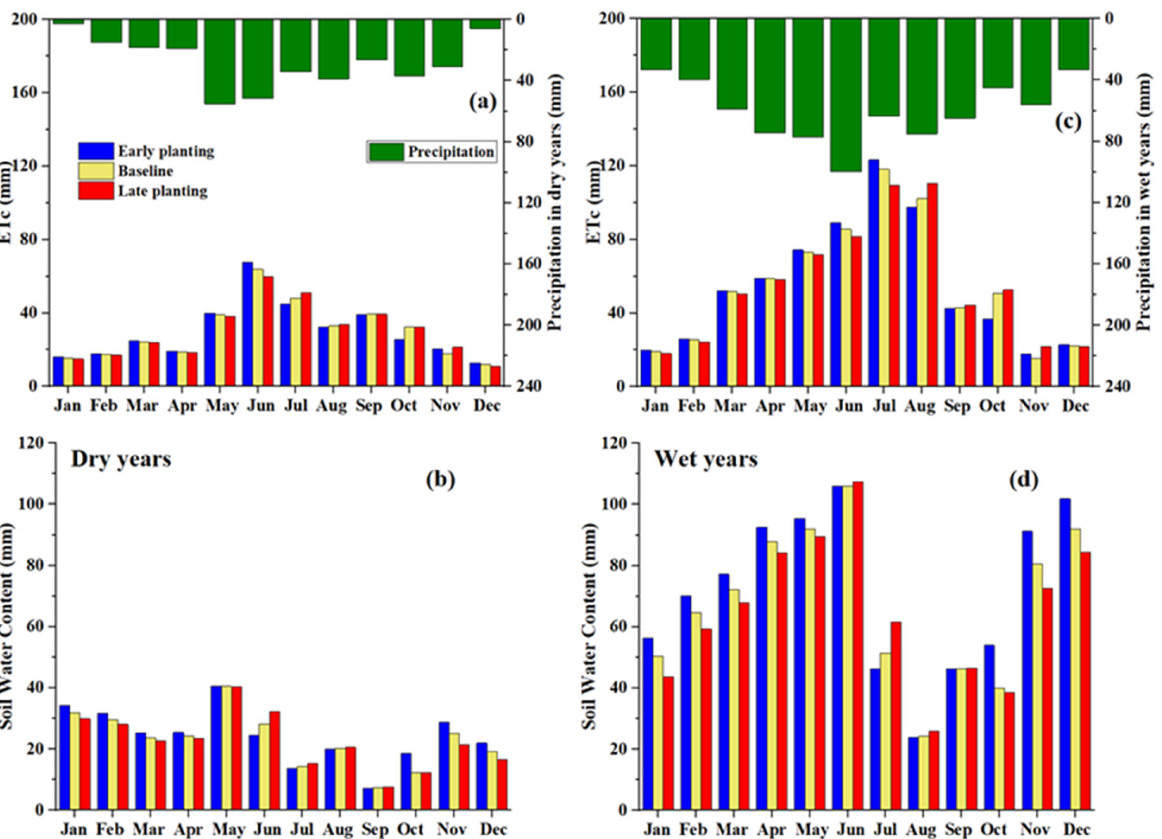
Figure 5 . Comparison of average monthly crop evapotranspiration (ET c ) ( a , c ) and soil water content ( b , d ) during dry and wet years using different planting dates in the dryland cotton HRUs in the Double Mountain Fork Brazos basin.